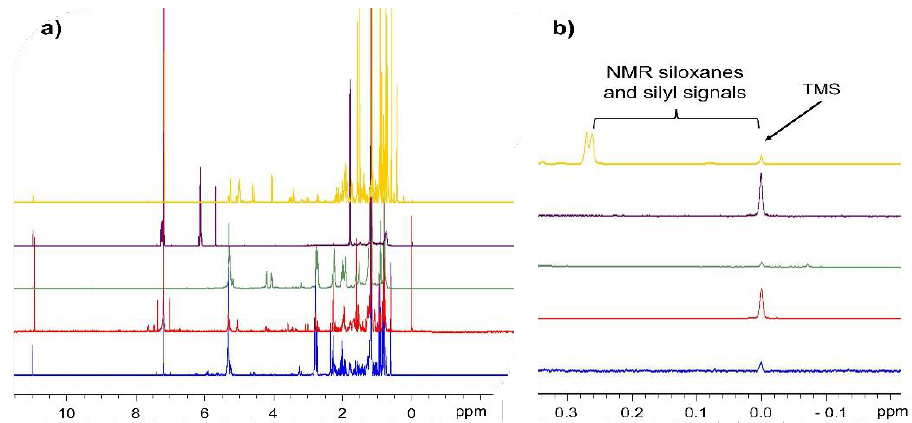
Figure 5. ( a ) Spectra of typical lipidic extracts from different foods: 1 H NMR spectra from bottom to top: surimi fish paste (blue); precooked octopus (red); mussels (green); strawberry jam (violet); unsaponifiable olive oil extract (yellow) in deuterated chloroform (CDCl 3 ). ( b ) Details from 0.3 to - 0.2 ppm free of NMR signals from 0.2 to 0.0 ppm (0.0 ppm of TMS reference signal in CDCl 3 ) where the PDMS and BSTMS signal appeared.